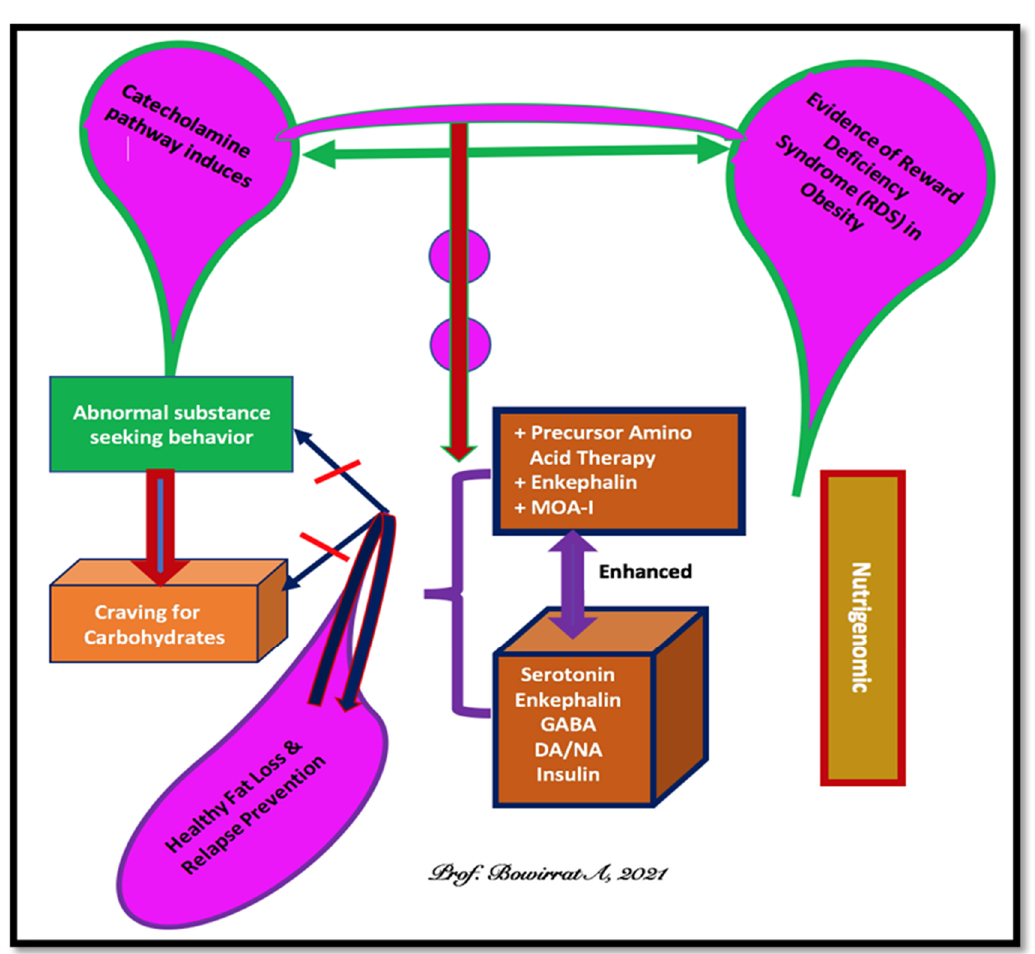
Figure 1. Neuro-Adaptogen and Amino-Acid-Therapy (NAAT) TM as a putative anti-obesity complex.